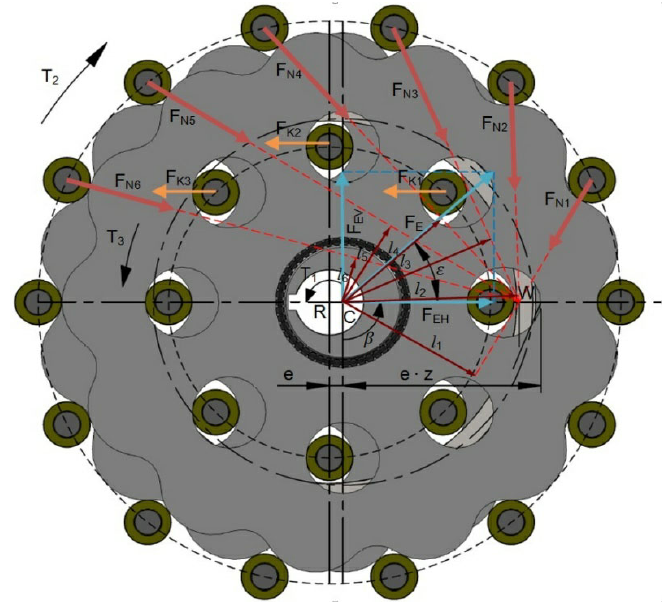
Figure 2. Forces on the cycloid disc [35].